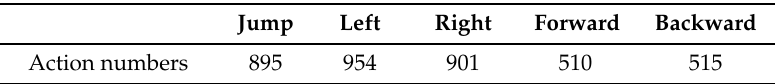
Table 2. Classification result of 10-fold cross validation.